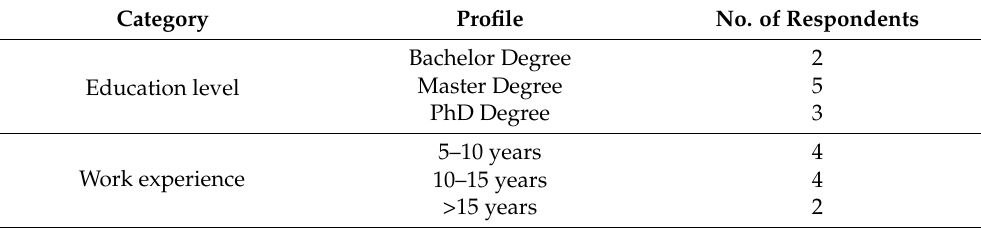
Table 4. The expert panel’s background